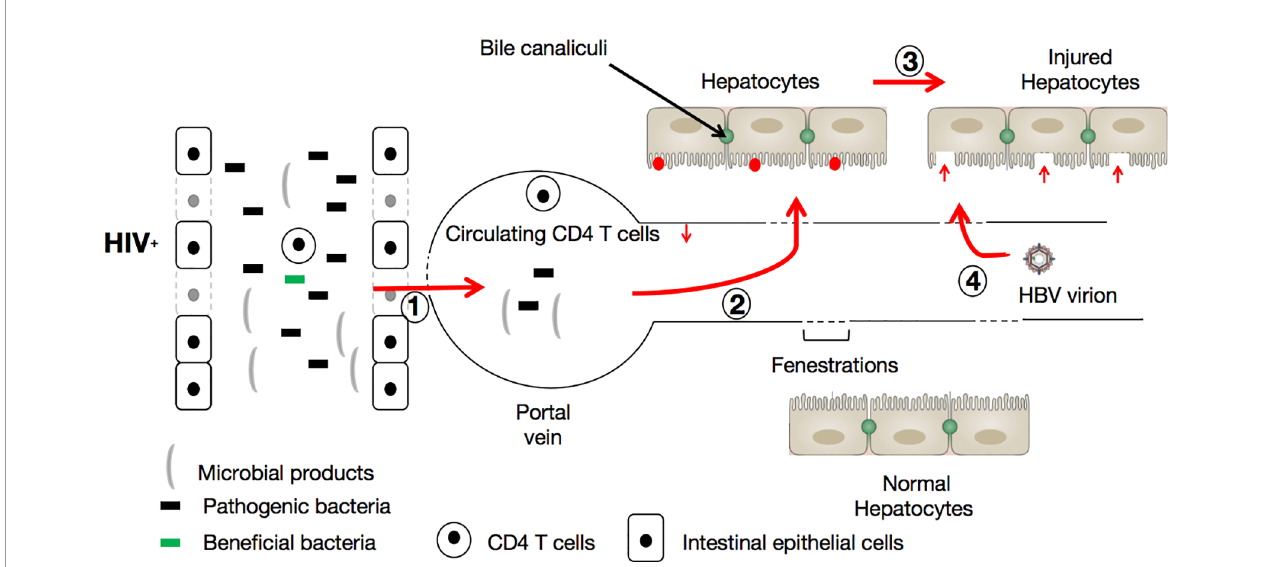
FIGURE 2 | HIV infection facilitates HBV infection via the triggering of the leaky gut syndrome. During HIV infection, immune cell (CD4+ T-cells, Th17, and Th22) depletion and bacterial diversity reduction in favor of potentially pathogenic microbe augmentation progressively allows microbes (including pathogenic bacteria) and their products to be translocated (1) into the circulatory system. Here, the translocated microbial products cause further depletion of CD4+ T-cells. Once in the portal vein, the translocated microbes and their products are able to reach hepatocytes (2) and activate the liver ’ s innate immune system (red points). Consequently, hepatocytes are damaged (3) by pathogen-associated molecular patterns (PAMPs) produced by intestinal microbes, and become vulnerable (red vertical arrows) to HBV incursion and infection